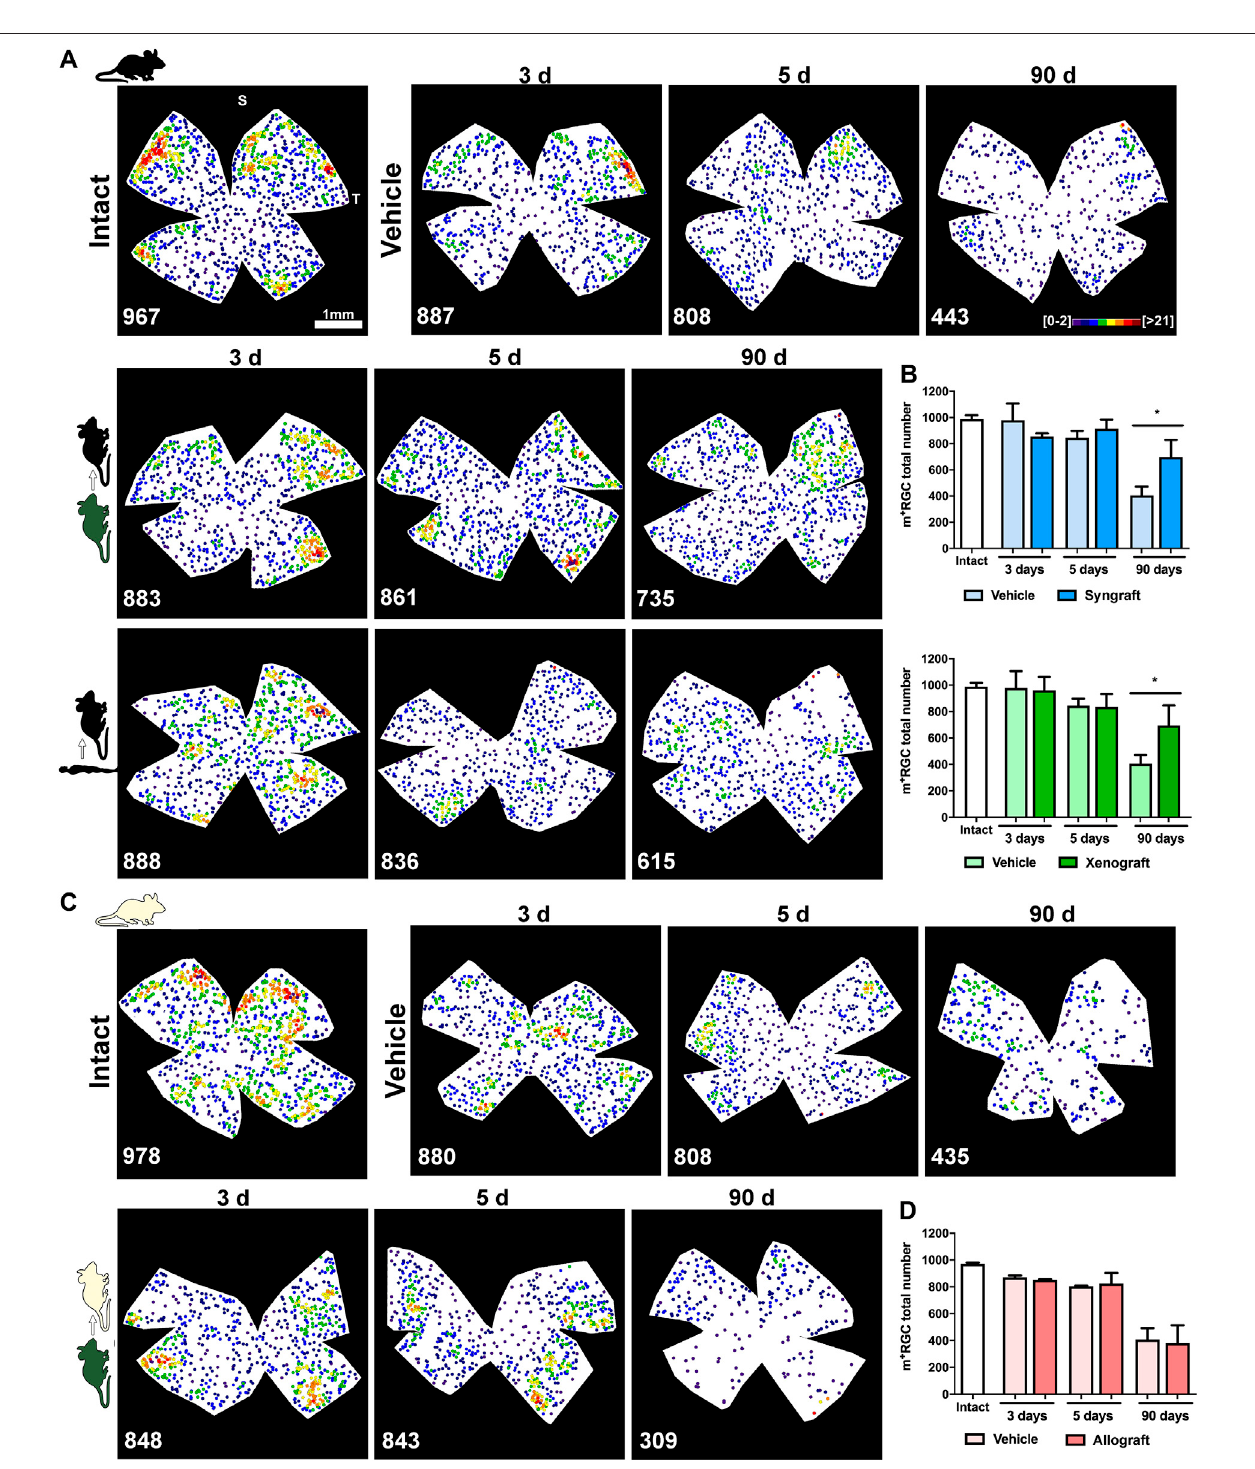
FIGURE 6 | Syngeneic and xenogeneic transplants neuroprotect non-vision forming RGCs. (A) : Representative neighbour maps showing the distribution of m + RGCs in intact, ONC + vehicle, ONC + mBM-MSCs and ONC + hBM-MSC retinas from the C57/Bl6 strain. (B) : Bar graphs showing the total number of m + RGCs ± SD in syngeneic (top) and xenogeneic (bottom) transplanted retinas and their controls (* p < 0.05, non-parametric Mann-Whitney test) (C) : Representative neighbour mapsshowingthedistributionofm + RGCsinintact,ONC+vehicleandONC+mBM-MSCsretinasfromtheBalb/cstrain. (D) :Bargraphsshowingthetotalnumber of m + RGCs ± SD in allogeneic transplanted retinas and their controls. At the bottom of each map is shown the number of m + RGCs counted in the original retina. Colour codes neighbour maps appear in the fi rst row. For more details see methods. n (cid:2) 5 animals/group/time point at 3 and 5 days, and n (cid:2) 4/group at 90 days.